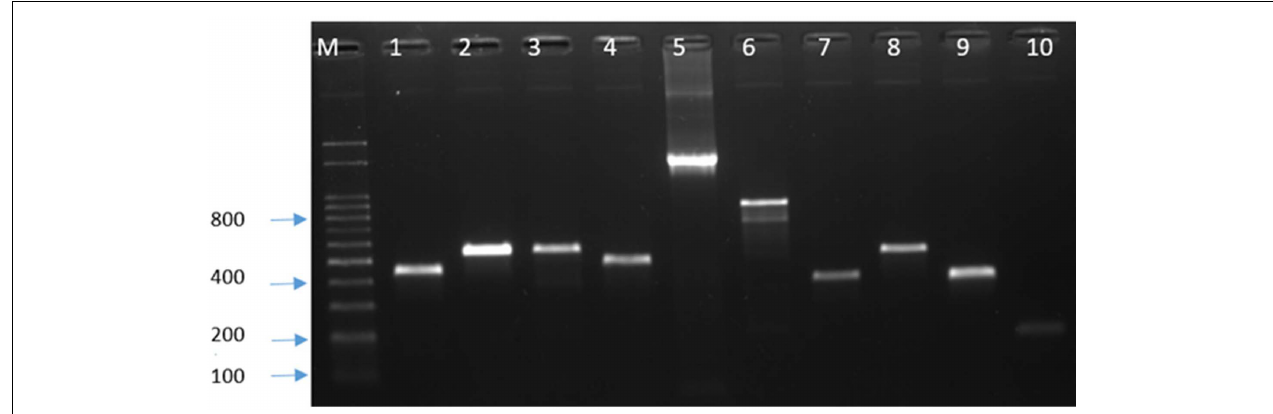
TABLE 1 | Antimicrobial resistance data for both Campylobacter jejuni and Campylobacter coli species. Anti- microbial